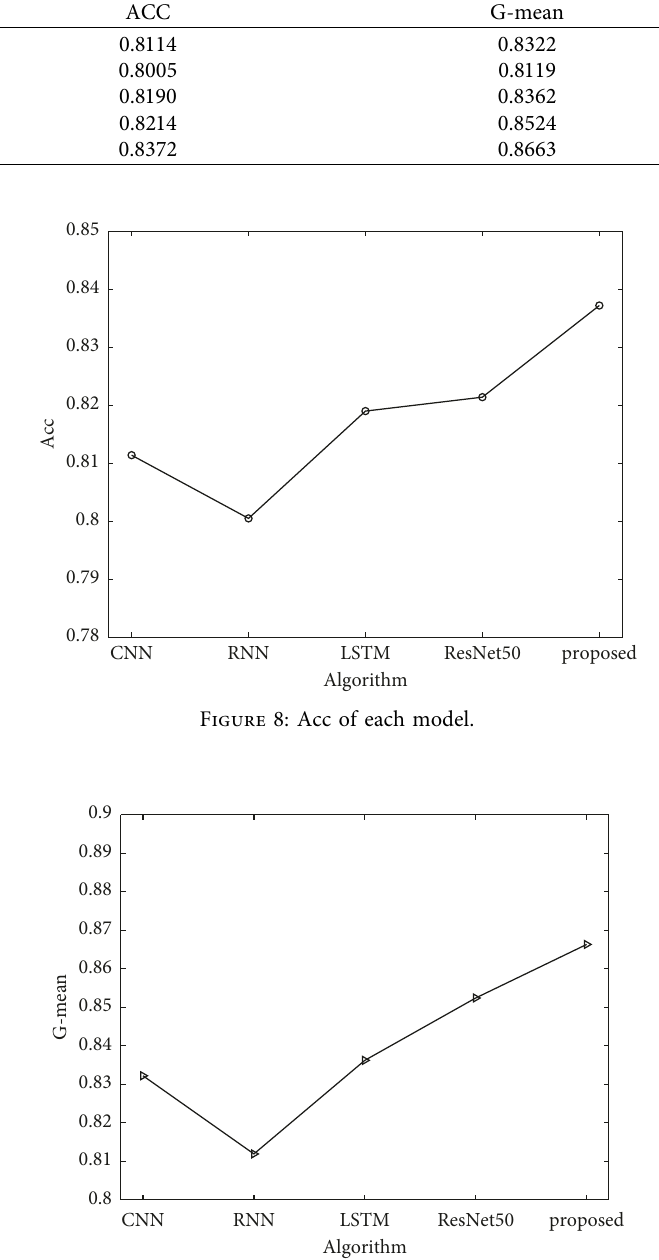
Figure 9: G-mean value of each